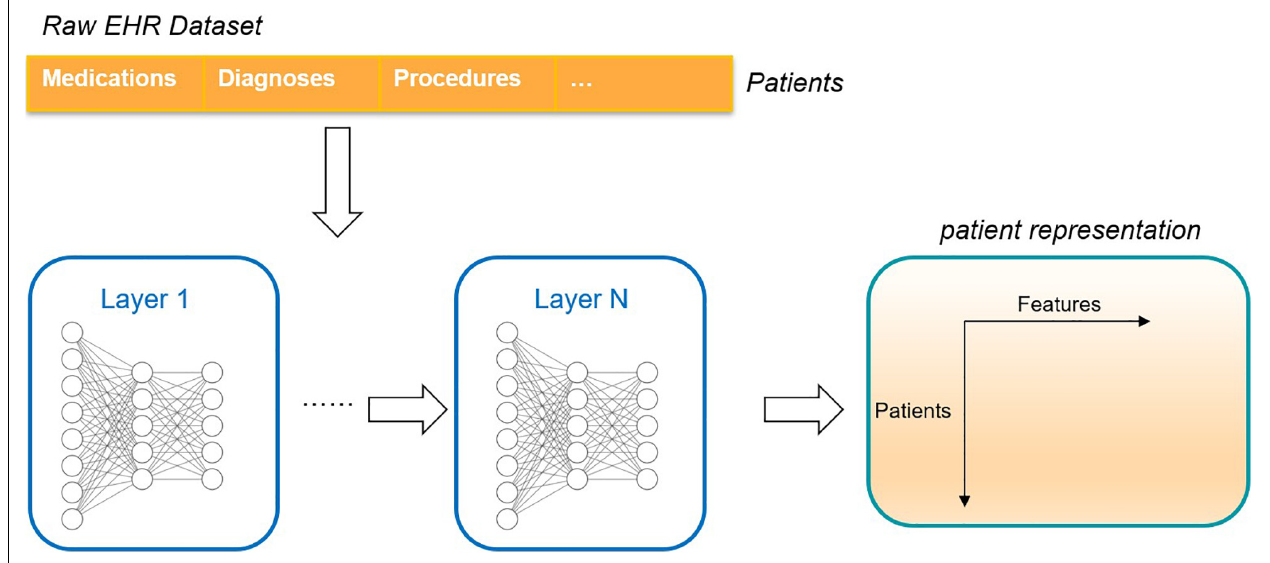
FIGURE 11 | An unsupervised deep learning framework that converts the raw electronic health record into a deep representation of the patient.